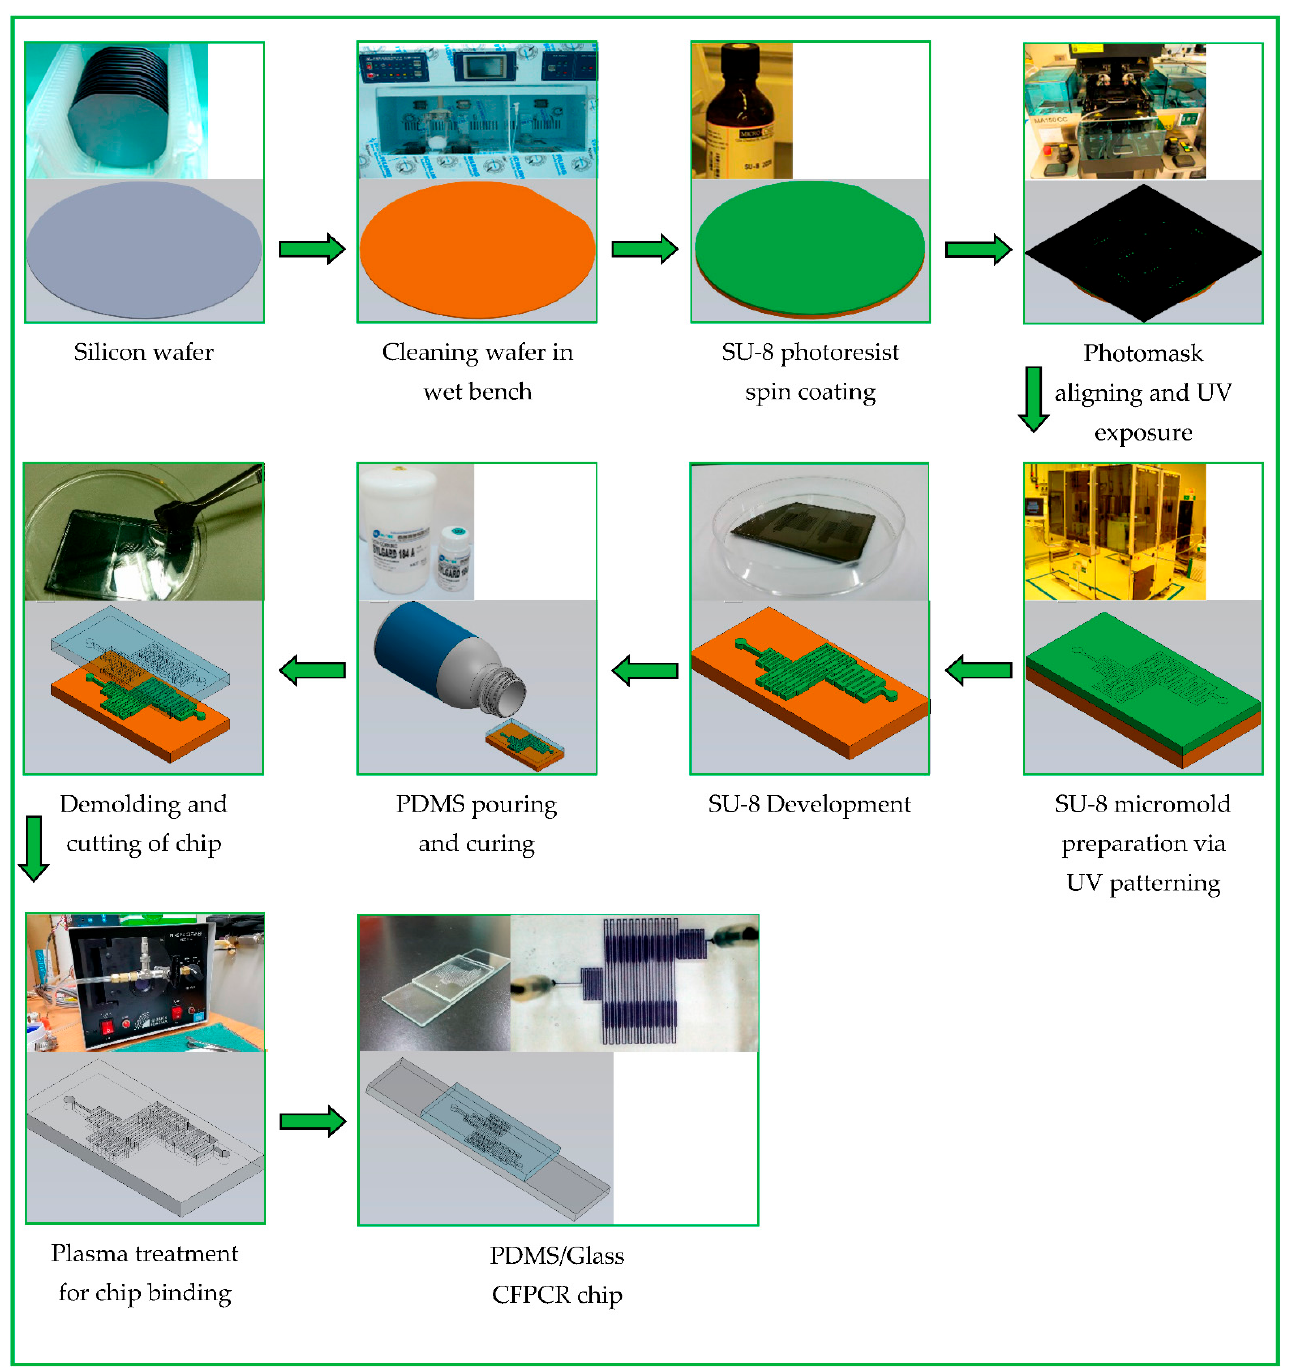
Figure 3. A photographic image and schematic diagram of the fabrication process of the CFPCR chip.